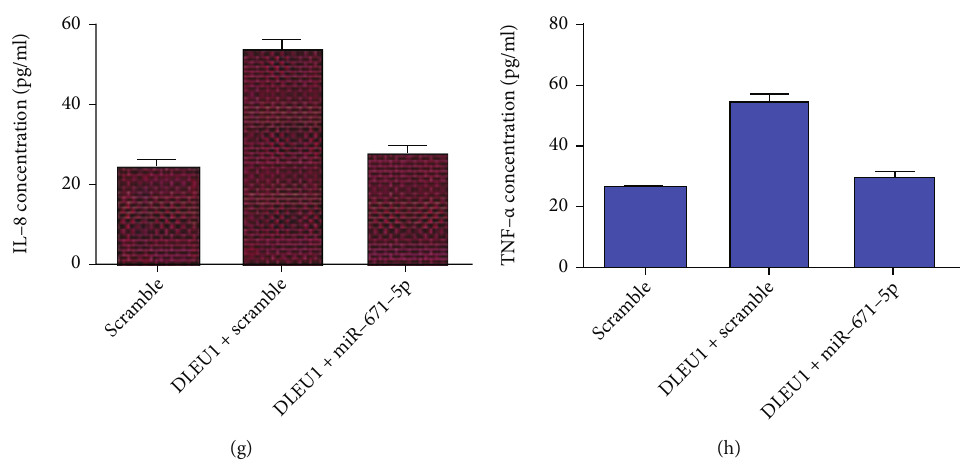
Figure 9: DLEU1 overexpression promoted chondrocyte proliferation, degradation of ECM, and in fl ammation mediator secretion via regulating miR-671-5p. (a) The cell proliferation was analyzed by CCK-8 assay. (b) The expression of collagen II was detected by qRT- PCR analysis. (c) The expression of aggrecan was detected by qRT-PCR analysis. (d) The expression of ADAMTS-5 was detected by qRT-PCR analysis. (e) The expression of MMP-3 was detected by qRT-PCR analysis. (f) The expression of IL-6 was measured by ELISA. (g) The expression of IL-8 was measured by ELISA. (h) The expression of TNF- α was measured by ELISA. ∗ p < 0 : 05 and ∗∗ p < 0 : 01